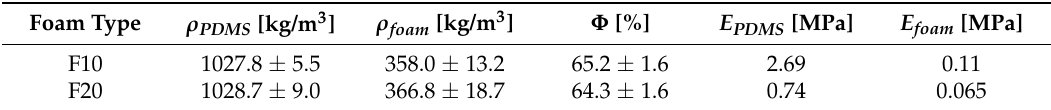
Table 1. Average physical characteristics of the produced PDMS foam samples, infiltrated or not with MLG suspension.